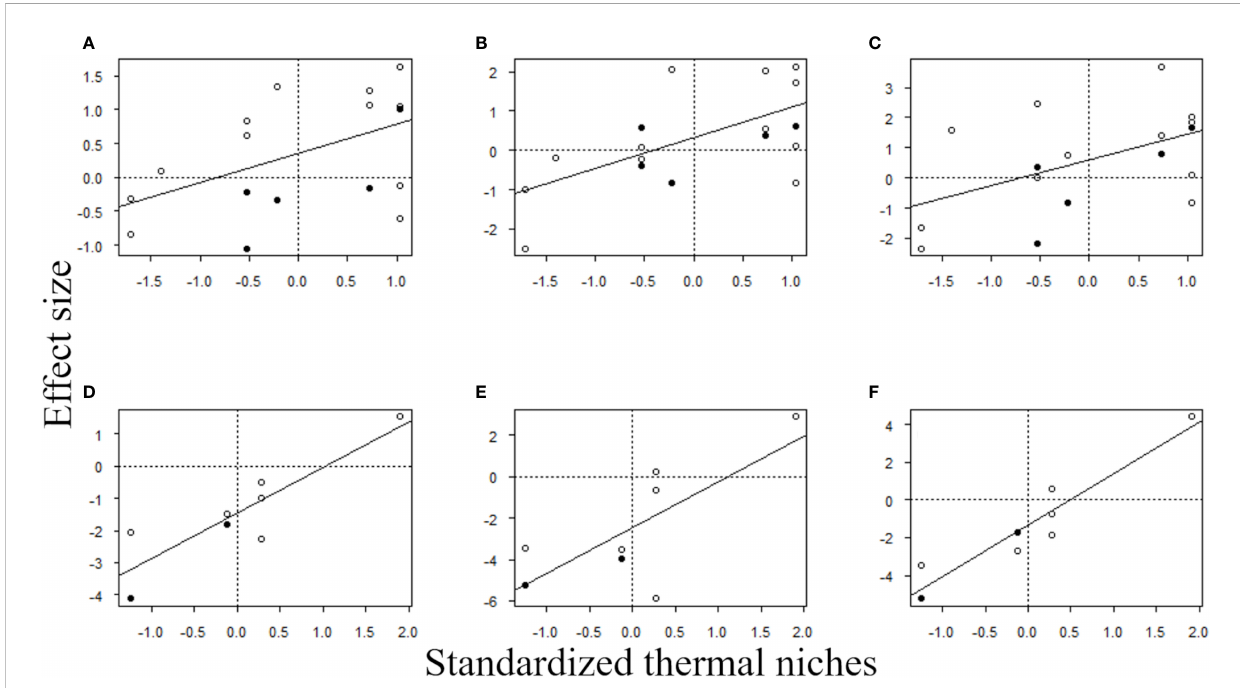
FIGURE 6 Relationship between the effect size of MHWs on species abundances of sessile and mobile organisms during the MHWs, and in the fi rst two years after the MHWs, and standardized thermal niches. Each plot includes the regression line for each model. (A) Sessile organisms during the MHWs, (B) sessile organisms in 2017, (C) sessile organisms in 2018, (D) mobile organisms during the MHWs, (E) mobile organisms in 2017, and (F) mobile organisms in 2018. The open circles in (A – C) indicate macroalgae and the fi lled circles indicate sessile invertebrates. The open circles in (D – F) indicate herbivorous mollusks, and the fi lled circles indicate carnivorous invertebrates.